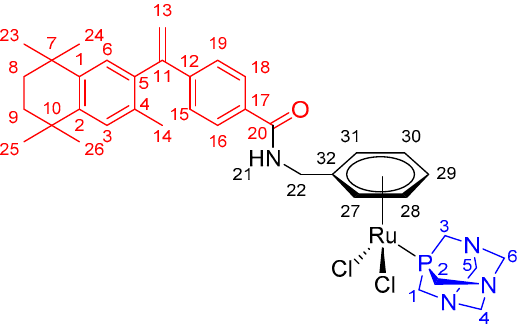
Figure 2. The structure of the target compound.